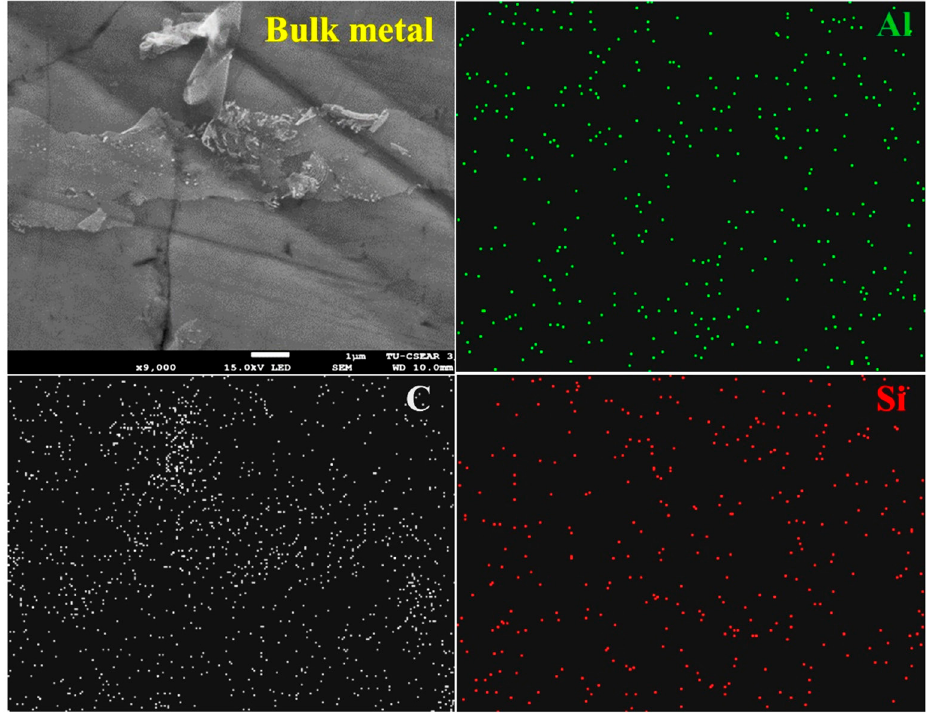
Figure 13. SEM micrograph and EDS elemental contour of the cross-sectioned metal droplet obtained from pellet (C/O = 2) after heating at 1550 °C for 3 h.